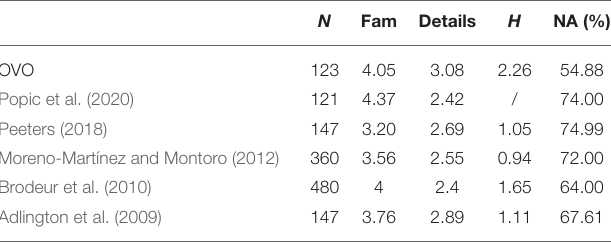
TABLE 4 | Overview of the standardized measures from the 3D objects in OVO (complete sample) and comparable databases.